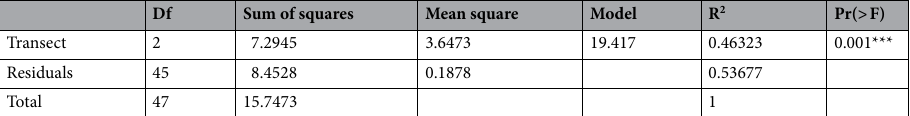
Table 3. PERMANOVA test results (n = 999) based on Bray–Curtis dissimilarity matrix for three elevation transects. ***(p ≤ 0.001).